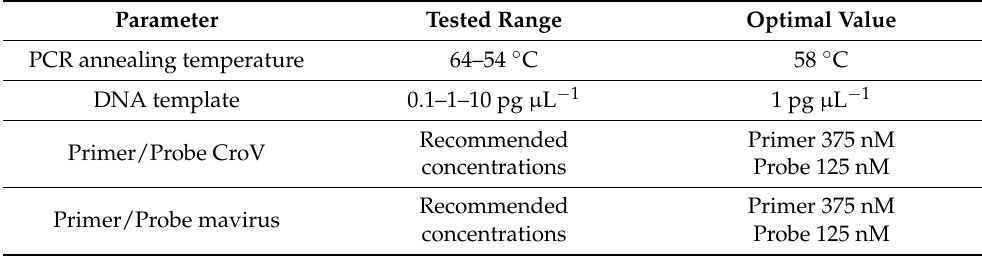
Table 2. PCR parameters for virus